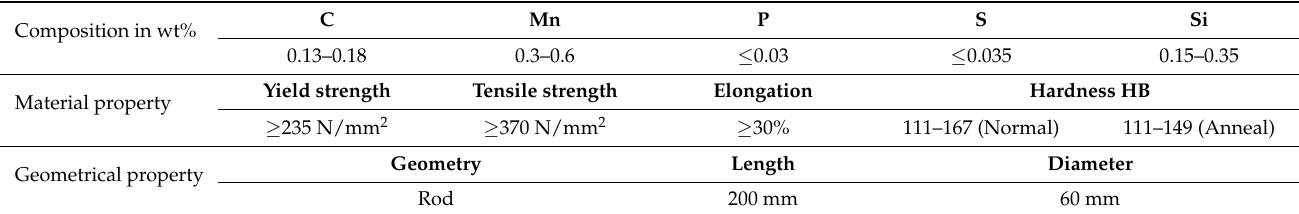
Table 2. The material and geometrical properties of the low carbon steel JIS S15C workpiece.